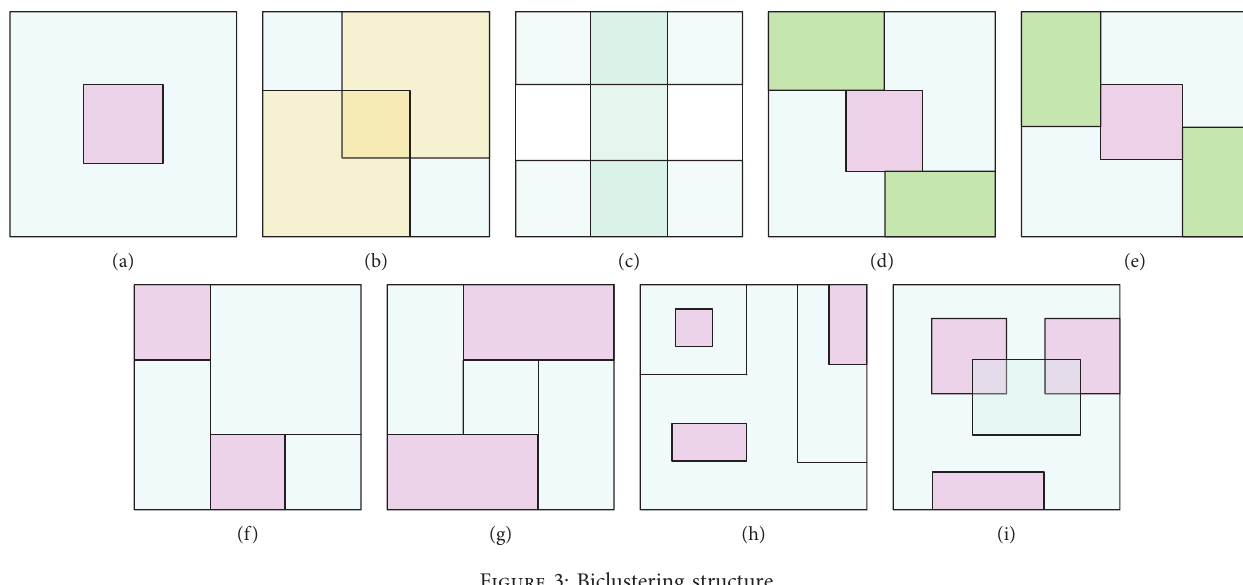
Figure 3: Biclustering